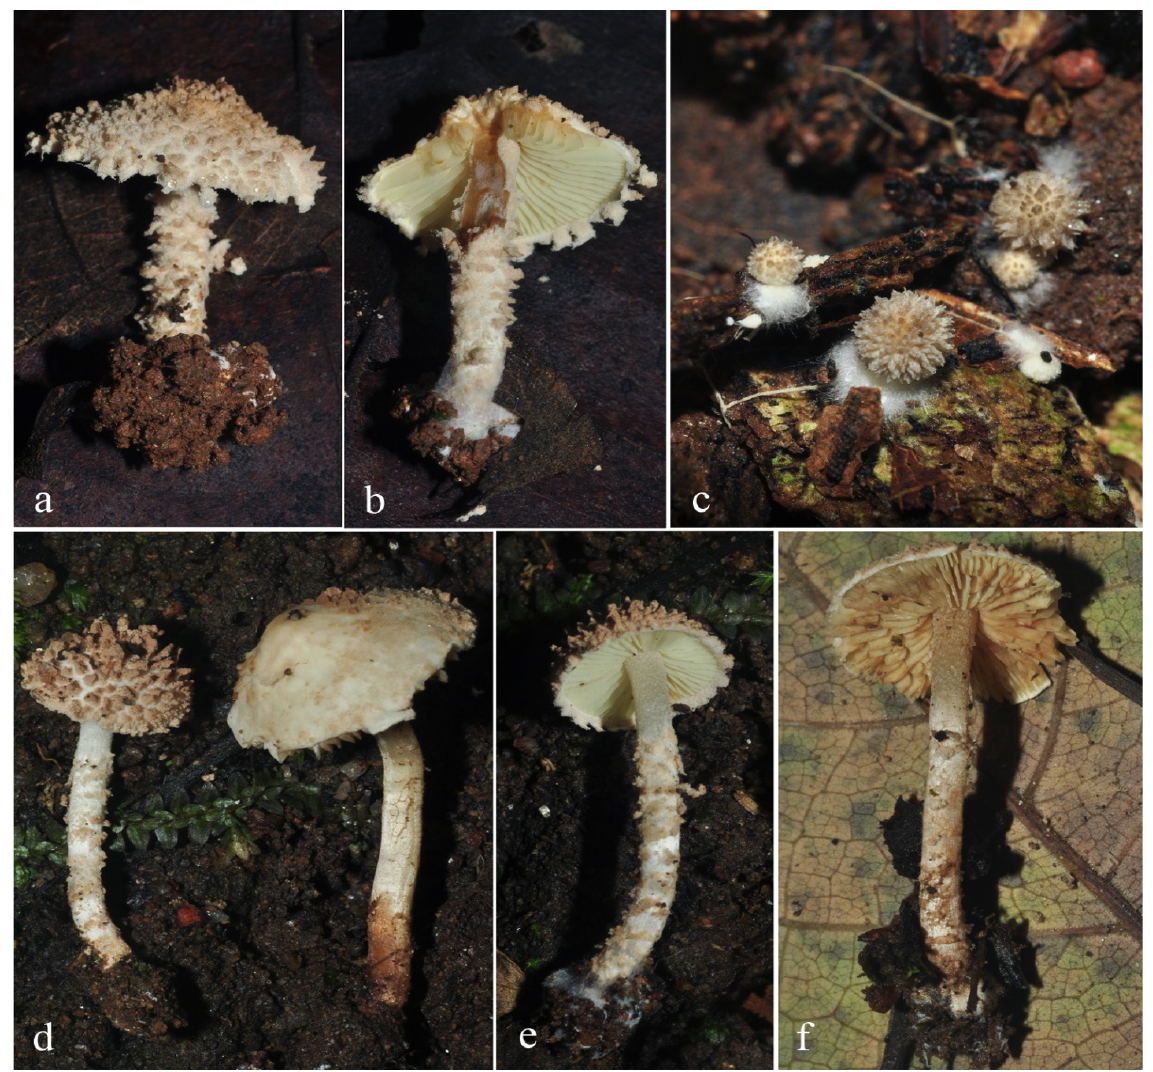
Figure 2 . Macrocharacters of Cystolepiota pyramidalis . ( a – c ) = MFLU12-1774 (paratype), ( d – f ) = HNL502500 (holotype).